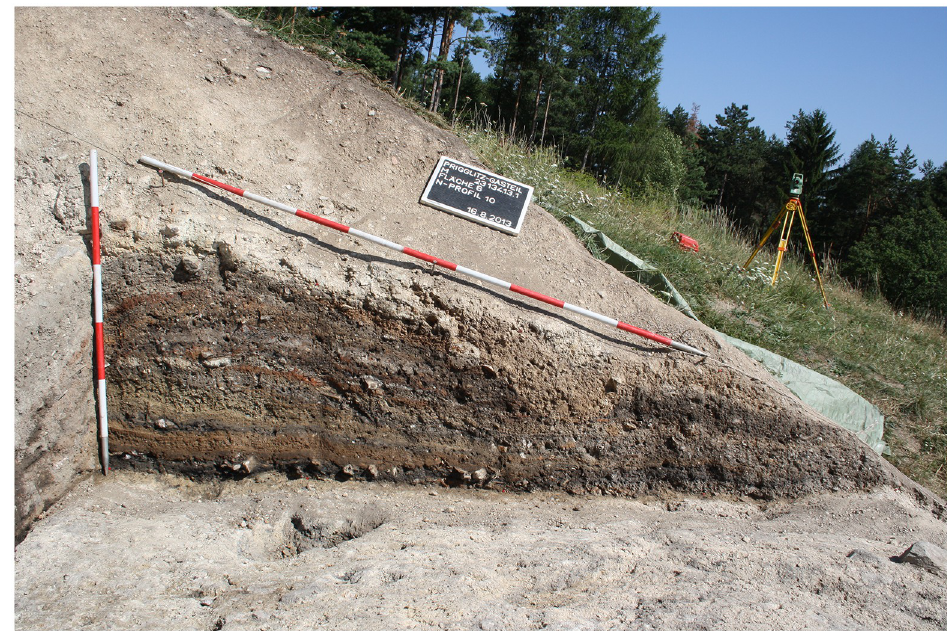
Fig 8. Photograph of the sediment layers on Terrace 3 (T3) at Prigglitz-Gasteil. Excavation area 6, profile 10. Image: UIBK/P. Trebsche.